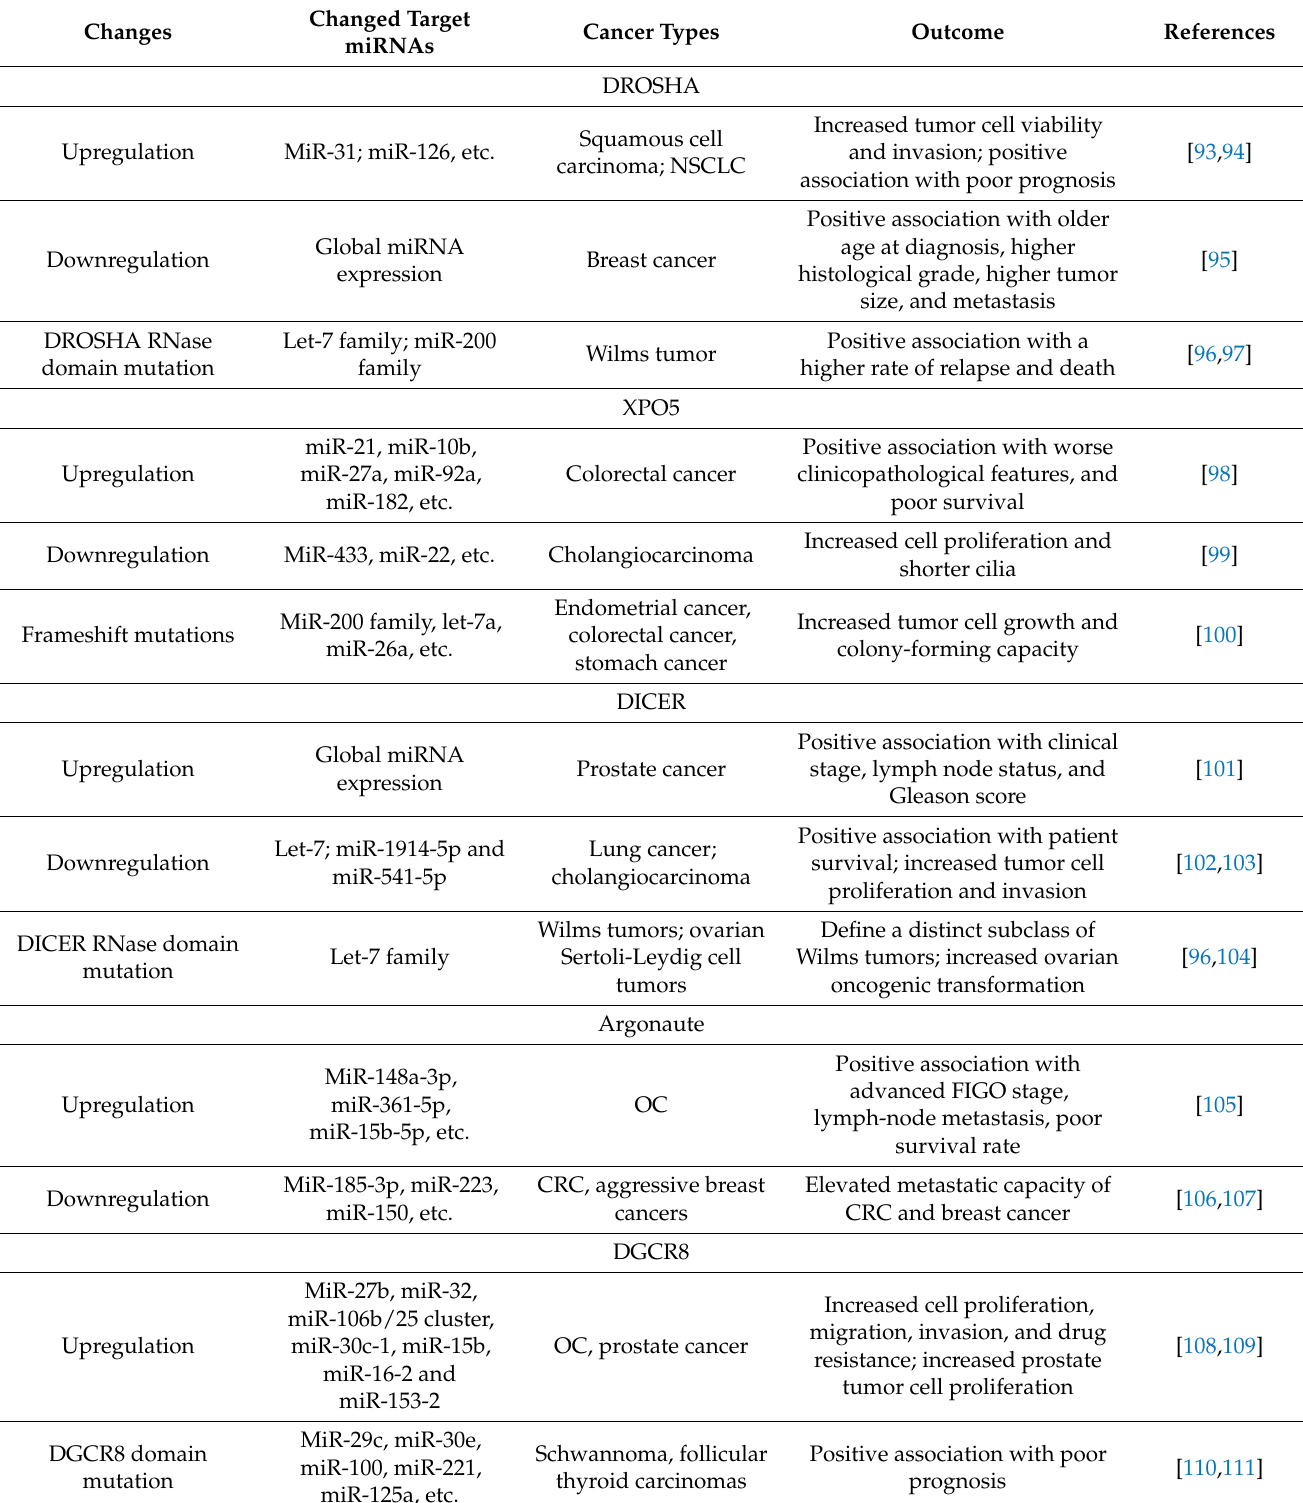
Table 1. The effect of abnormalities in miRNA processing-related